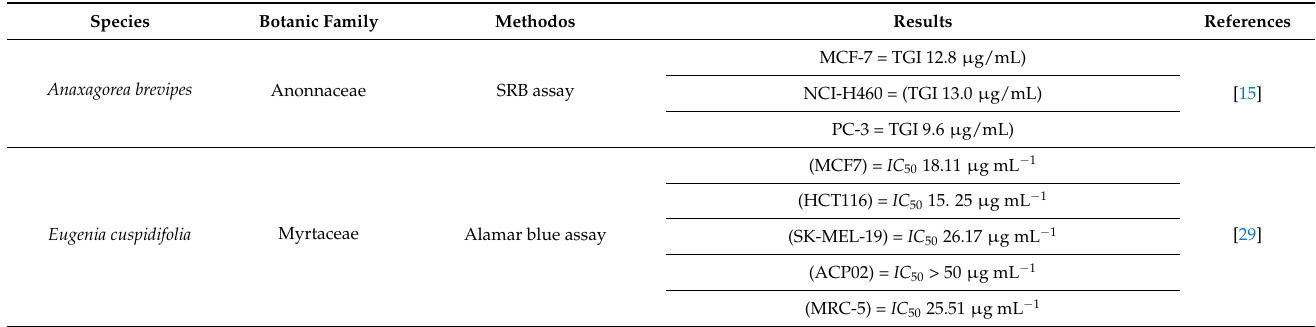
Table 5. Cytotoxic activity of essential oils from species found in the